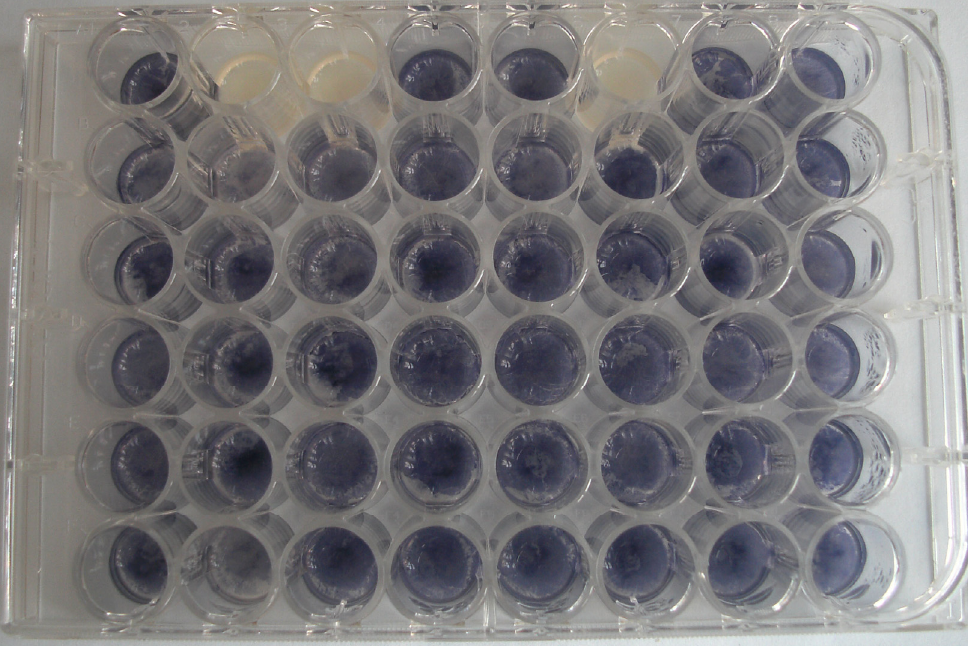
Figure 1. Identification of bacteria isolated from tobacco phyllosphere. Each tested isolate was incubated with 10 μ M N -(3-oxohexanoyl)- L -homoserine lactone (3OC6-HSL) for 24 h after which the residual AHL was detected by C. violaceum CV026. A purple violacein indicates the presence of